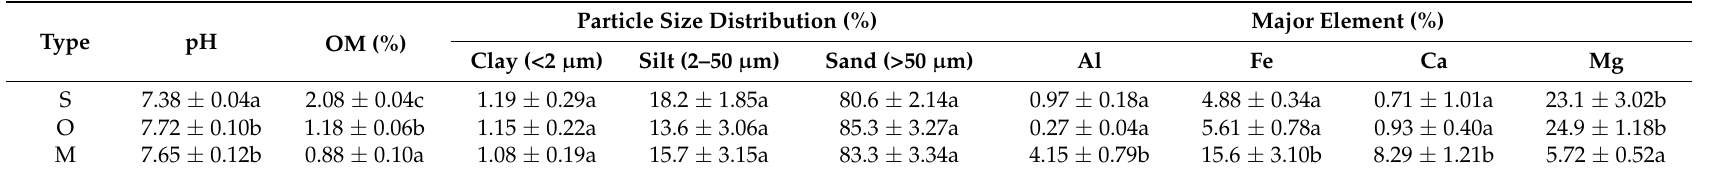
Table 1. Physicochemical properties of three-type tailing soils in this study.